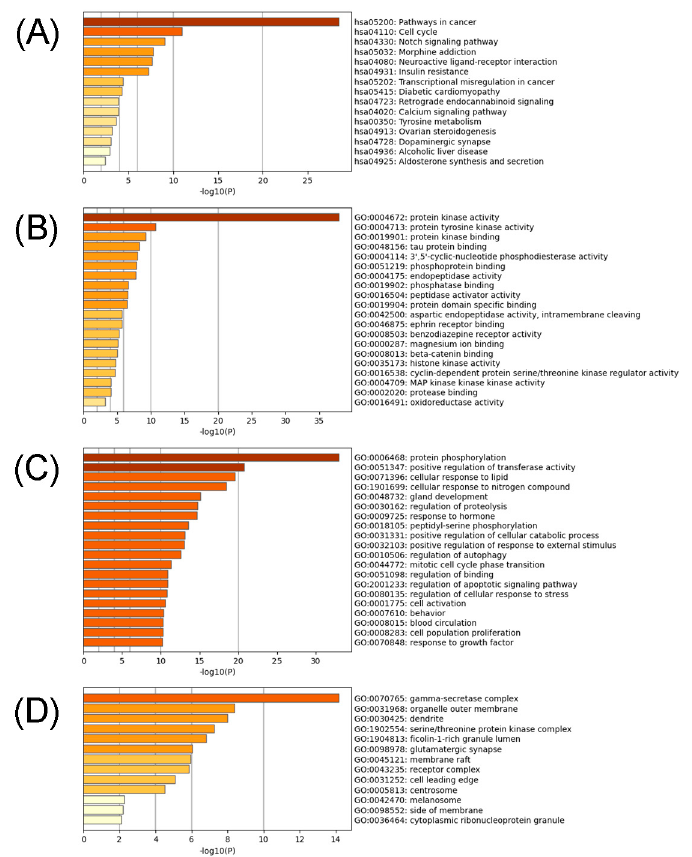
Figure 5. GO annotation and KEGG pathway enrichment analysis. ( A ) KEGG pathway analysis; ( B ) GO molecular function analysis; ( C ) GO biological process analysis; ( D ) GO cellular component analysis.